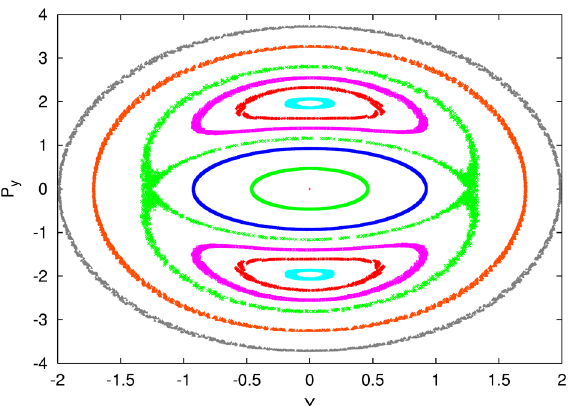
FIG. 14. (Color) Stroboscopic map of the particle vertical phase space in the uniform-focusing lattice with envelope mismatch M (cid:9) 0 : 300 and for a beam intensity equal to one- half of the full beam intensity listed in Table I. The coordinates are normalized to the mismatched envelope.